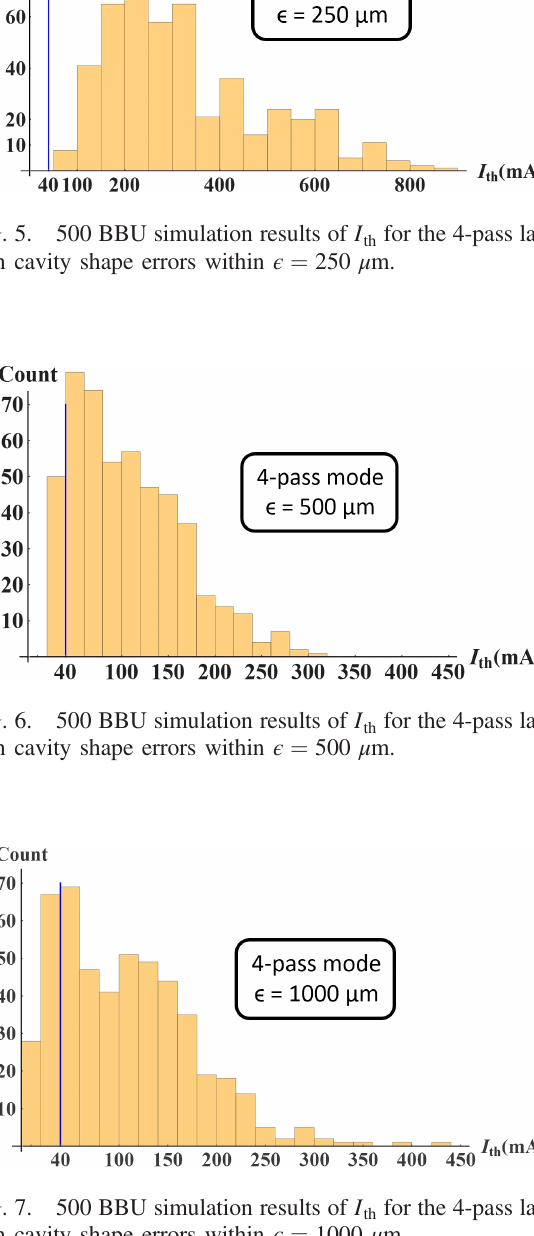
for the 4-pass lattice th